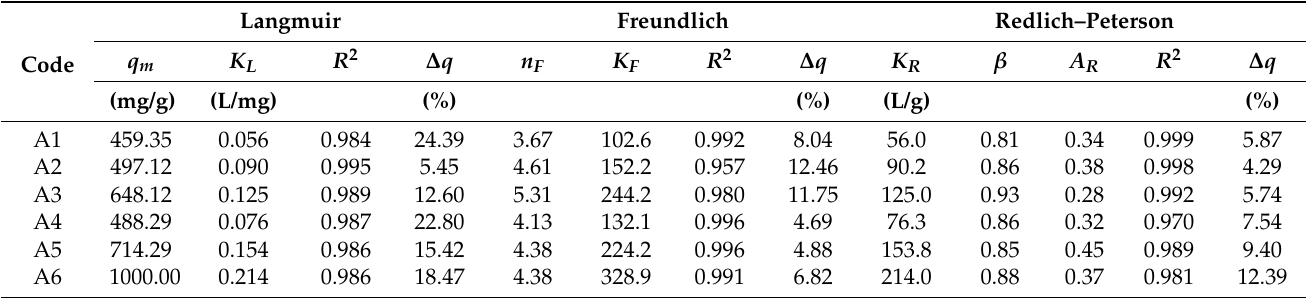
Table 8. The maximum adsorption capacity of methylene blue from solutions ( q m ) by activated carbons prepared from various materials and activation methods.